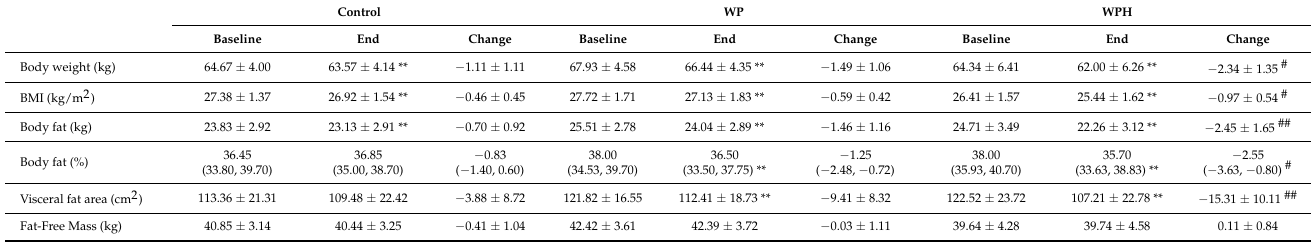
Table 3. The changes in body composition among the three groups.